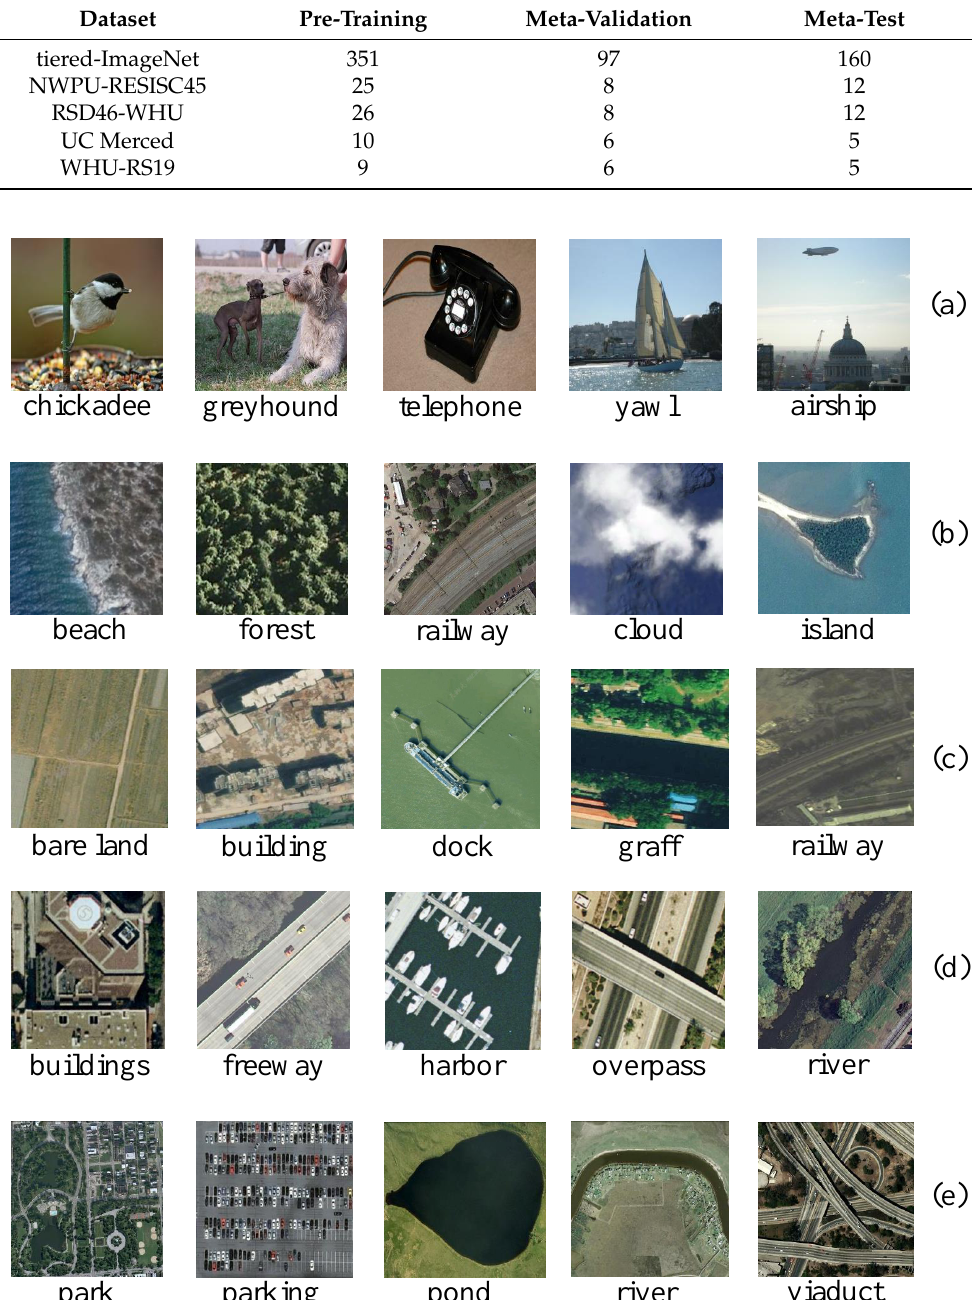
Table 1. Category information of datasets.